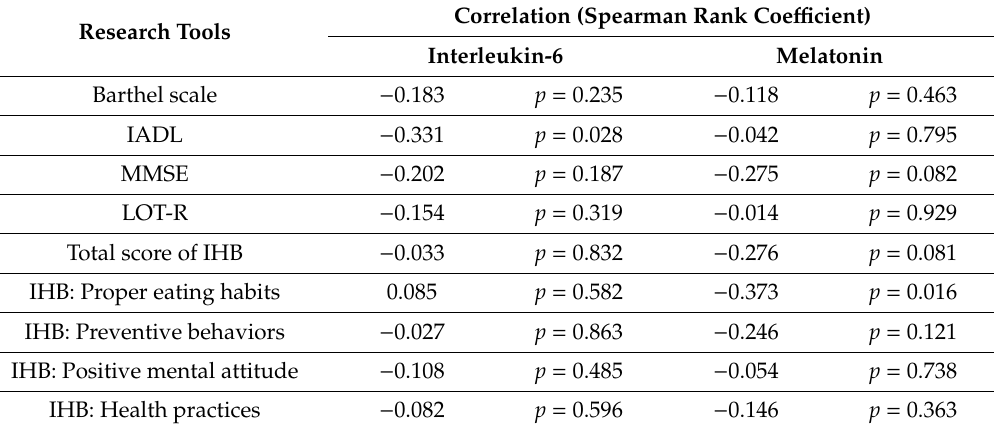
Table 7. The relationship between the level of interleukin-6 and melatonin and the results obtained from standardized research tools among respondents over 75 years old belonging to the study group (n = 66).